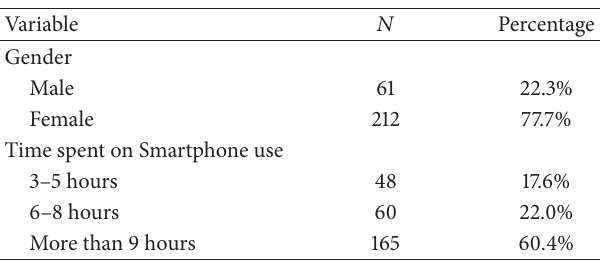
Table 1: Respondents’